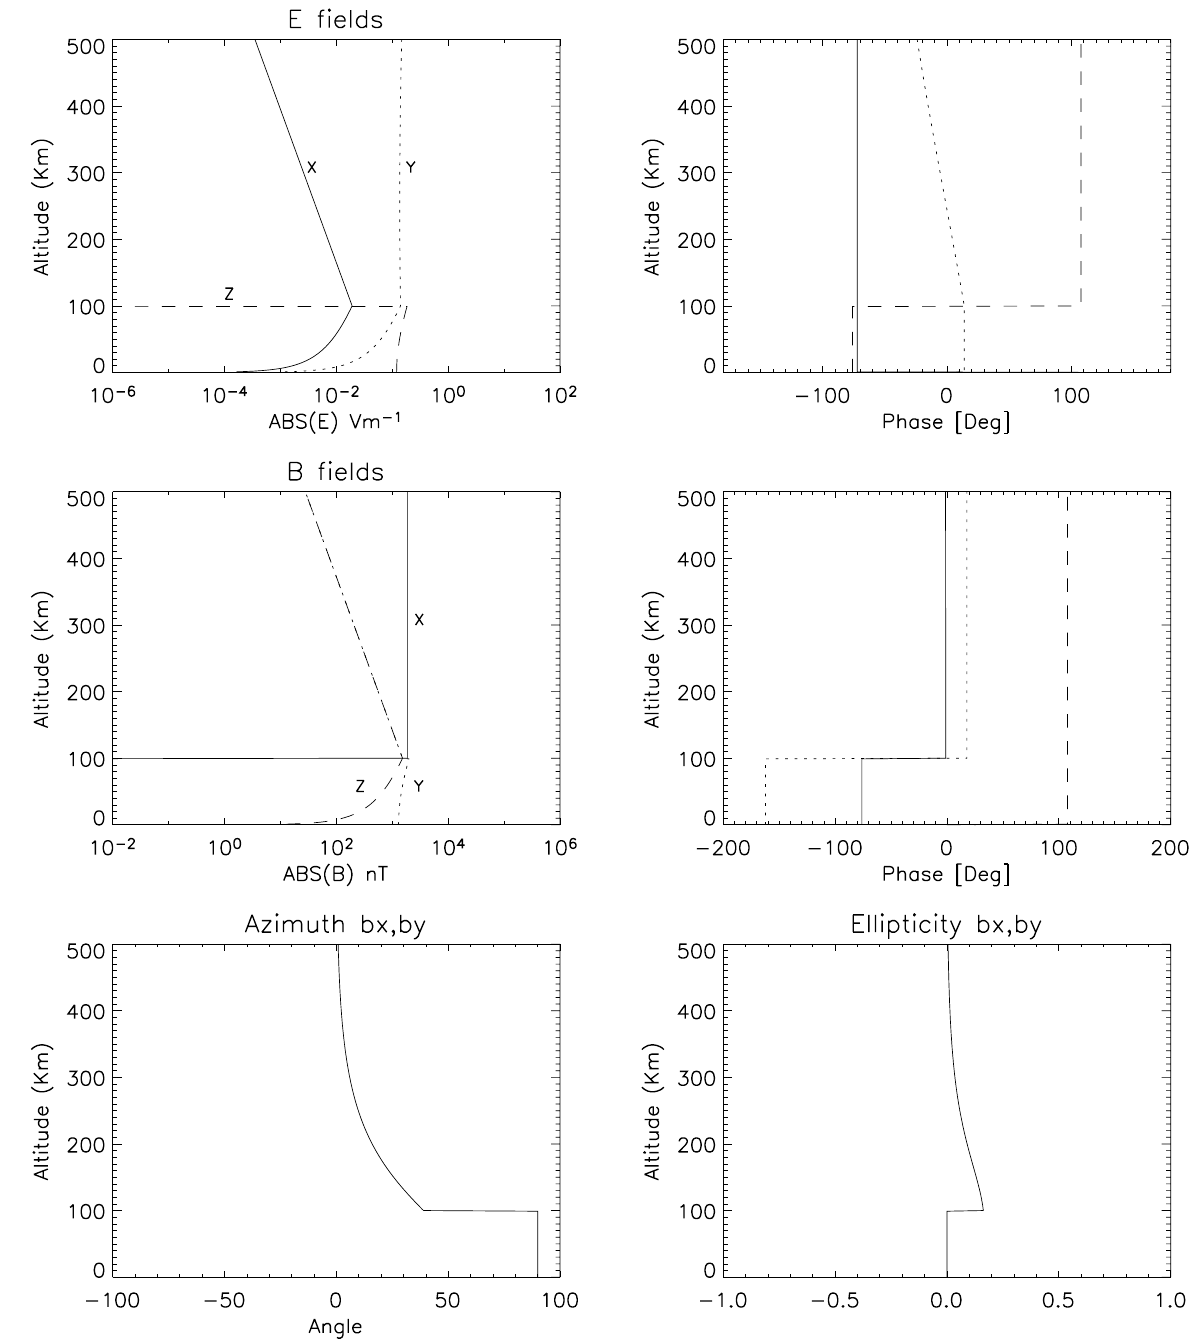
Fig. 2. ULF wave fields for vertical B 0 , k x = 0, k y =1/d, d=100km, V a =1 × 10 6 ms − 1 , f=20mHz, α P =10 and α H =20. The wave fields are X (solid), Y (dotted) and Z (dashed). The azimuth panel shows the NDR.